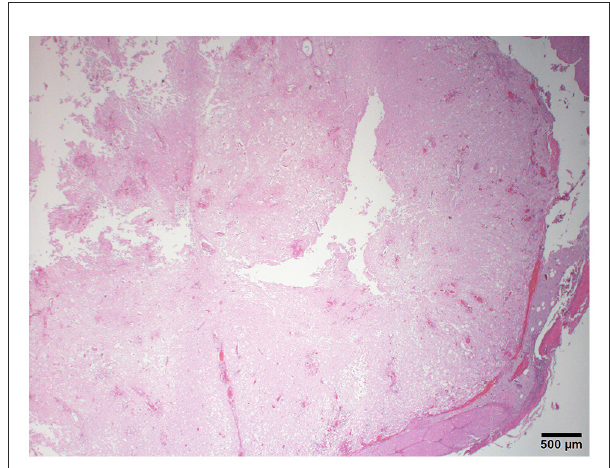
FIGURE3 Photomicrograph of the cervical spinal cord with multifocal hemorrhage, severe tissue loss, cavitation, and lack of distinction between the gray and white matter. H&E